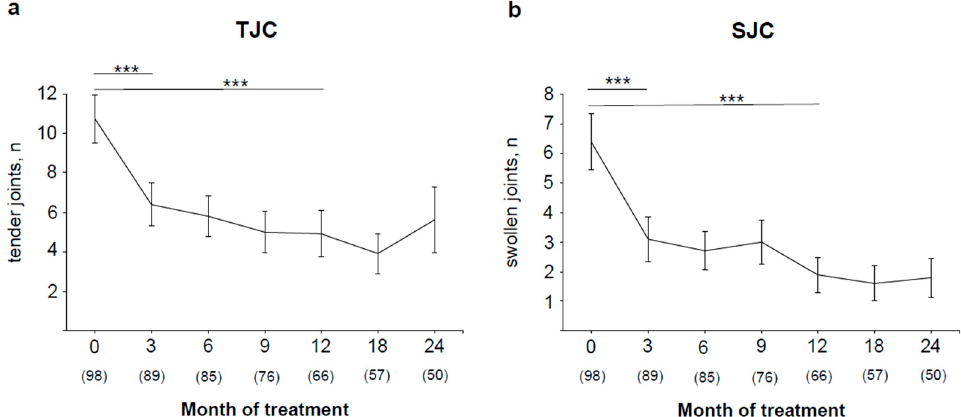
Figure 2. Overall improvement of ( a ) tender joints and ( b ) swollen joints during therapy. Absolute number of tender and swollen joints (mean ± SEM) and total number of patients per visit are shown. *** p < 0.001.